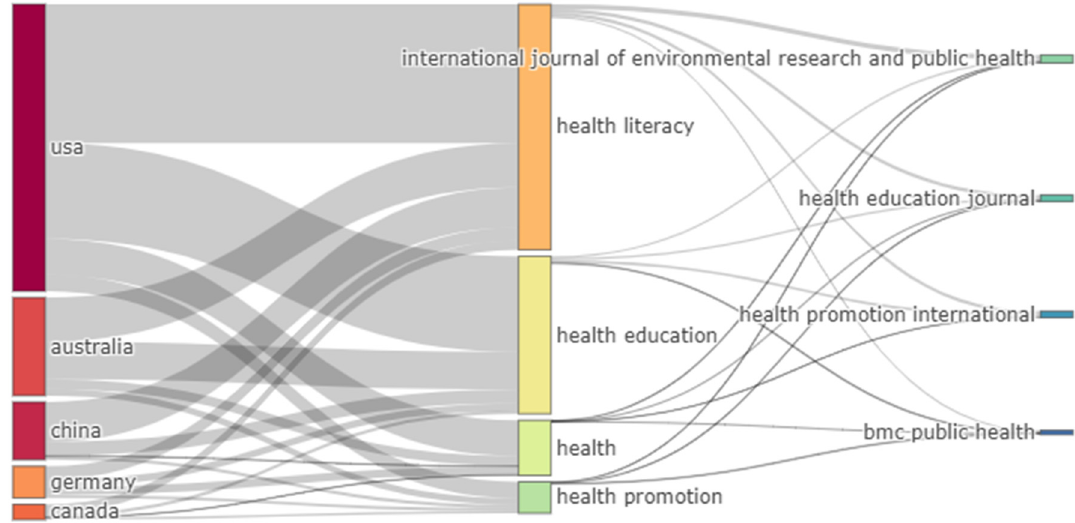
Figure 13. Summary plot of interactions between the most productive countries ( left ), the most relevant author keywords ( centre ) and the most relevant sources ( right ).